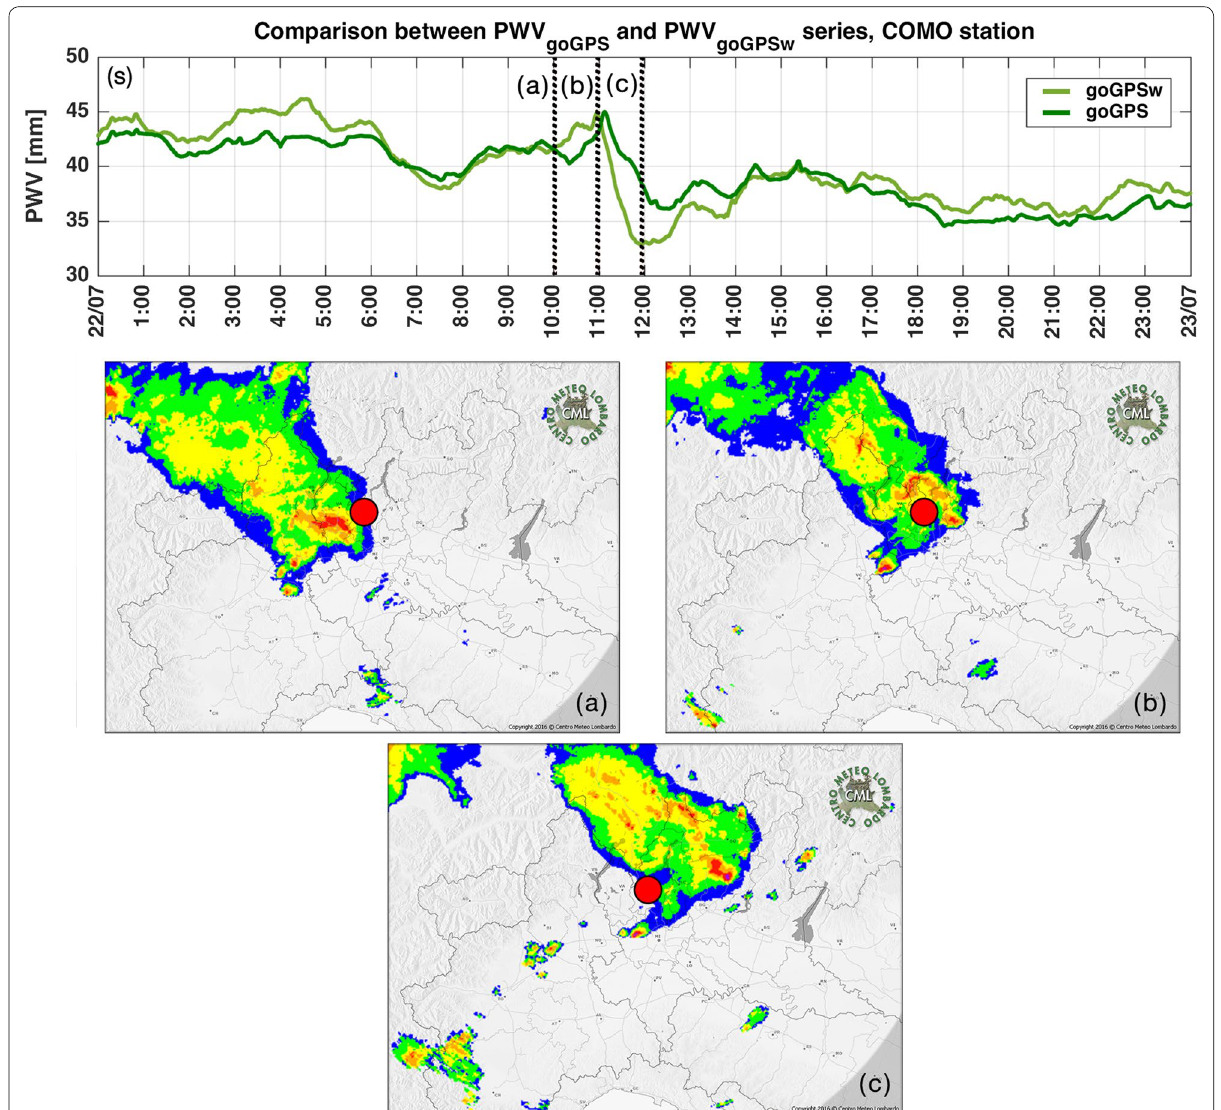
Fig. 9 In the subfigure(s), the COMO station PWV goGPS and PWV goGPSw time series. On the bottom, radar images corresponding to a the epoch when the precipitation starts passing over the station, b to the epoch when it completely surrounds the station, and c to the epoch when it starts leaving the